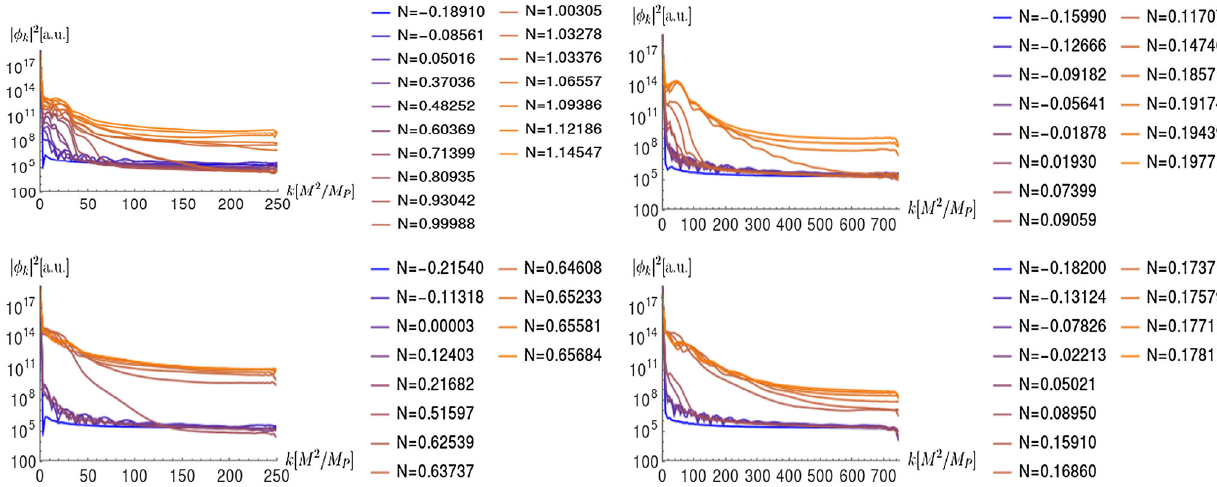
Fig. 10 The power spectrum of the inflaton perturbations for n = 1 , α = 10 − 3 (upper left), n = 1 , α = 10 − 4 (upper right), n = 1 . 5 , α = 10 − 3 (lower left), n = 1 . 5 , α = 10 − 4 (lower right) for different number of e-folds N after the end of inflation